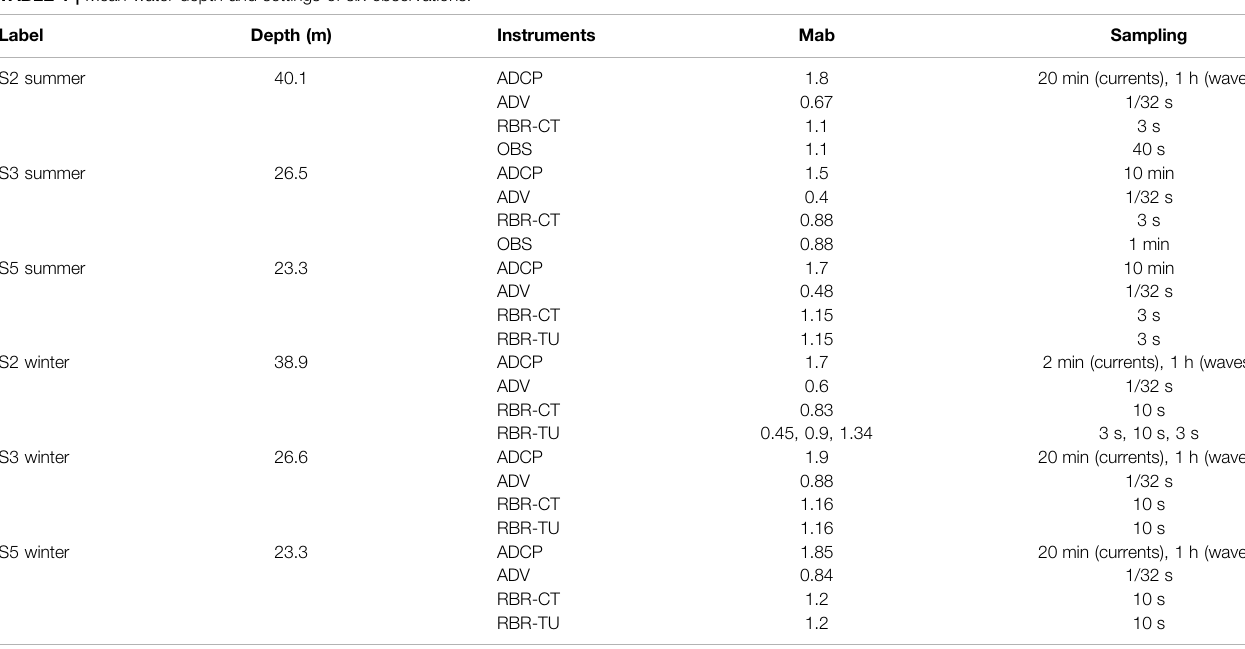
TABLE 1 | Mean water depth and settings of six observations.